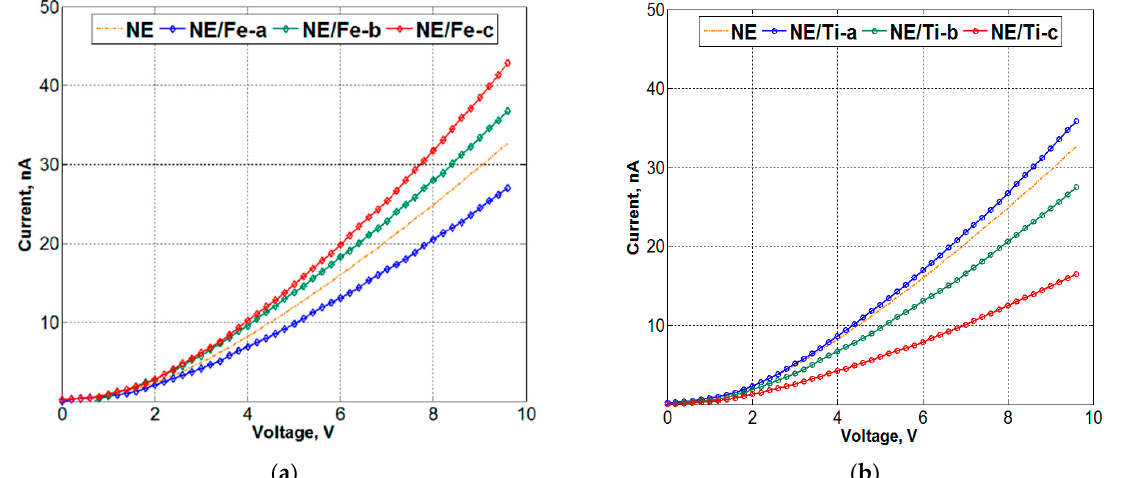
Figure 9. Current–voltage curve for natural ester containing ( a ) conductive and ( b ) semiconductive nanoparticles [29].